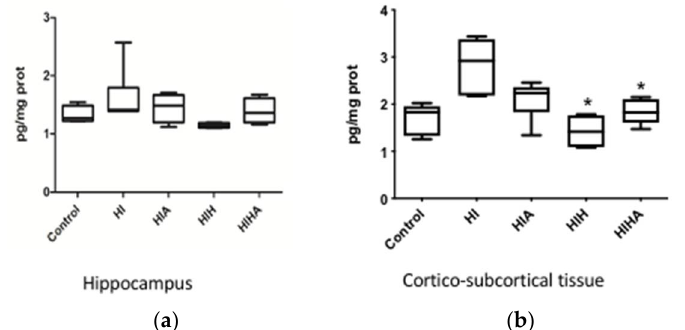
Figure 5. ( a ) Box plot of F2-isoprostane levels in hippocampus tissue. ( b ) Box plot of F2-isoprostane levels in cortico-subcortical tissue . C: Control, HI: Hypoxia-ischemia, HIA: Hypoxia-ischemia + allopurinol, HIH: Hypoxia-ischemia + hypothermia, HIHA: Hypoxia-ischemia + hypothermia + allopurinol. * p < 0.05 in post-hoc analysis compared to HI.